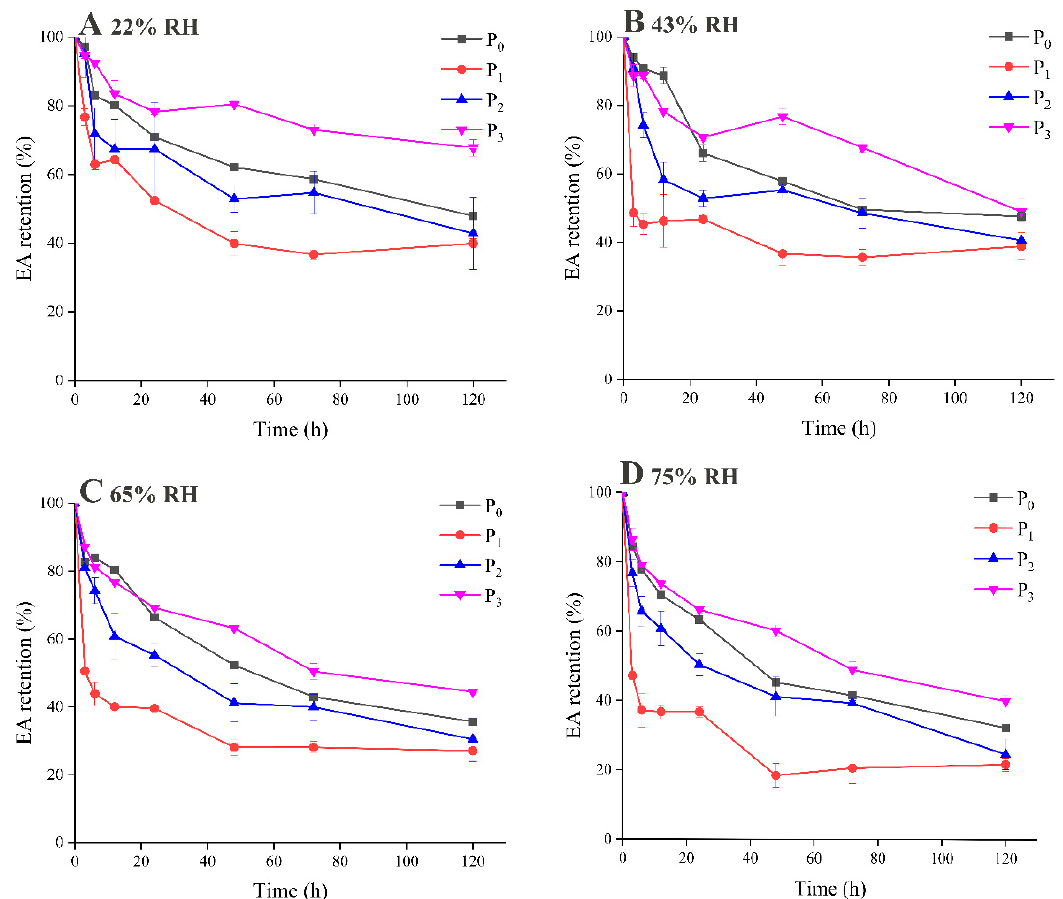
Figure 3. Ethyl acetate (EA) retention of powdered microcapsules at relative humidity (RH) 22% ( A ), 43% ( B ), 65% ( C ), 75% ( D ) during storage.